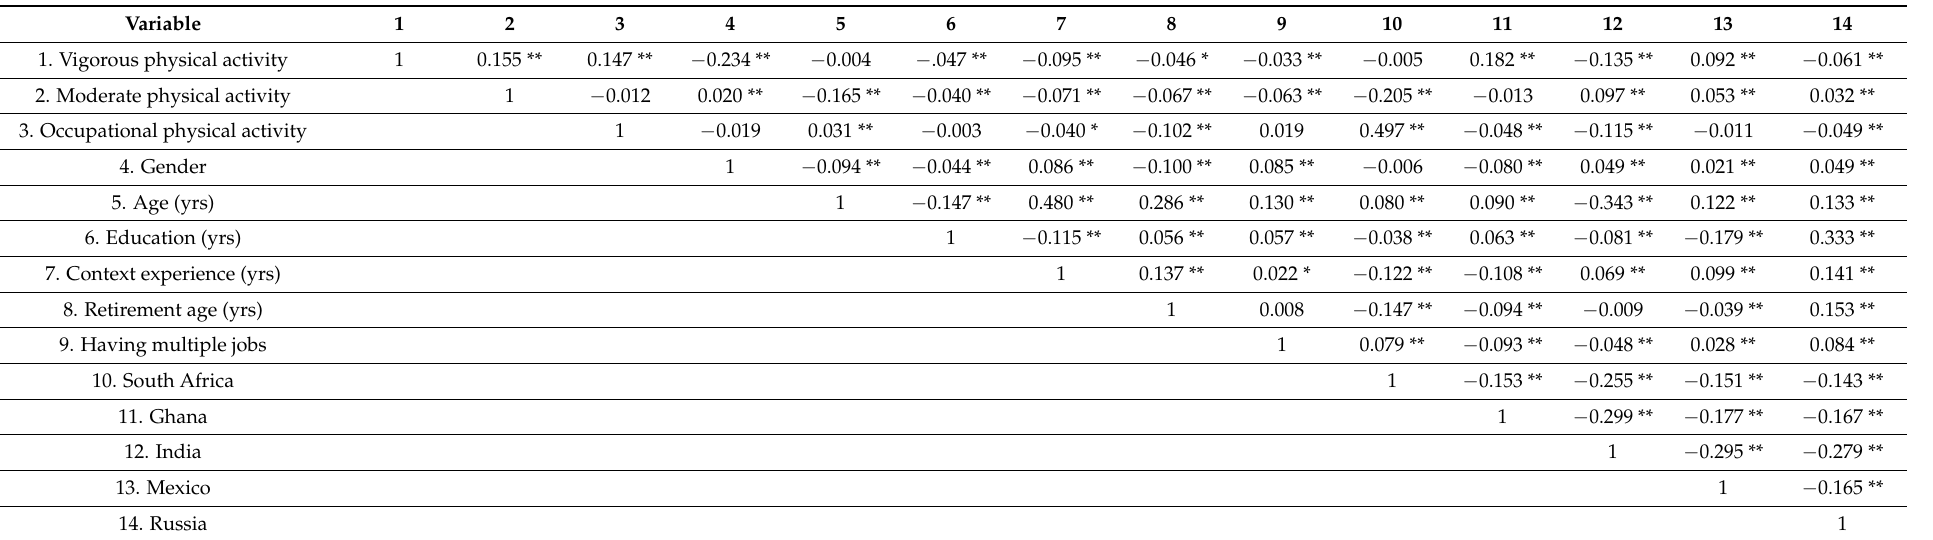
Table A2. Bivariate correlations between key variables of the